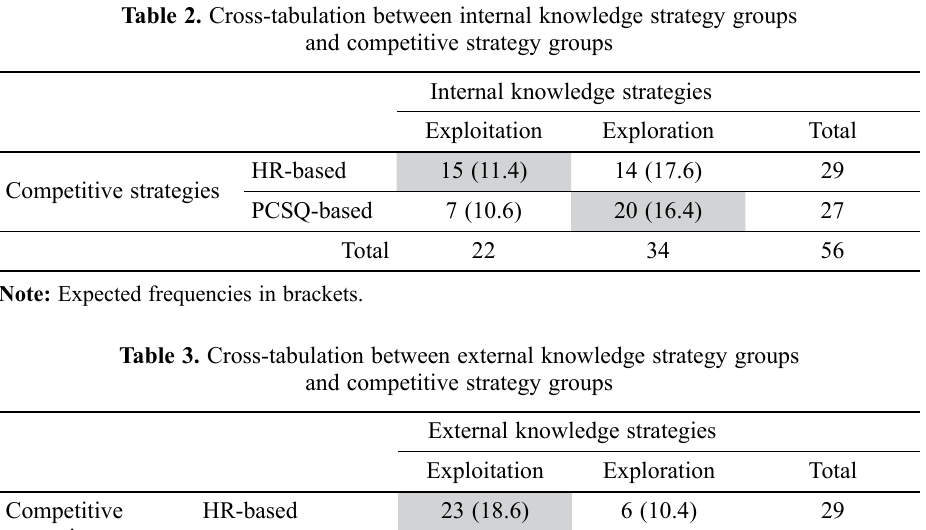
Table 2. Cross-tabulation between internal knowledge strategy groups